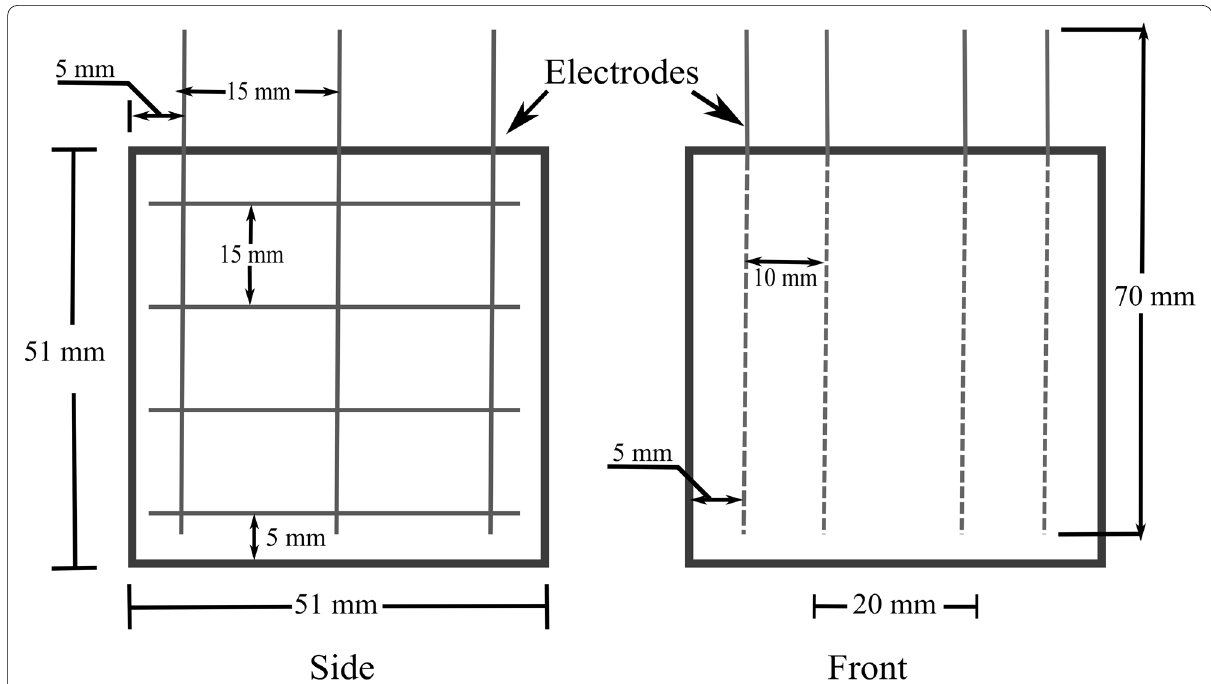
Fig. 2 CBM/CNT specimens and copper electrodes mesh‑type